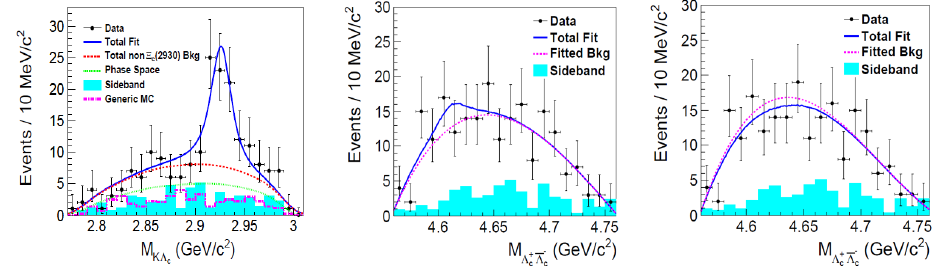
¯ Λ − (b) Λ + with Y η (left) and Y (4660) (right) signals c c c